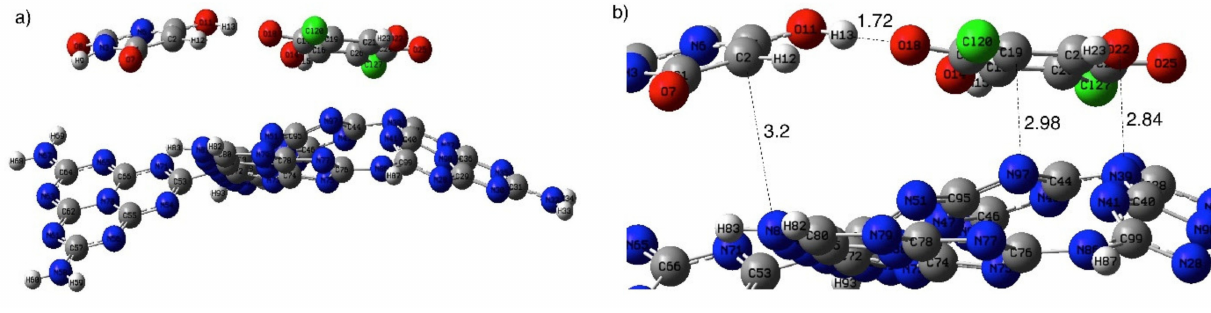
Figure 7. Optimized structure of ( a ) BUChA/g-C 3 N 4 and ( b ) enlarged BUChA/g-C 3 N 4 structure in the gas